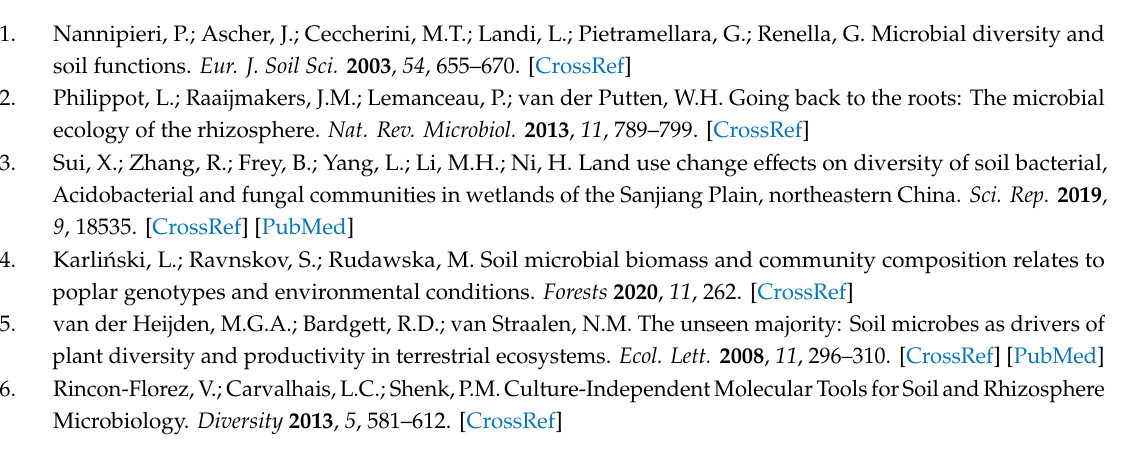
Table S1: T-RFs detected in a treatment of soil classified as Brunic Arenosol (S1) DNA sample after HaeIII digestion of the ( a ) 16S rDNA bacteria, ( b ) 16S rDNA archaea, ( c ) ITS1 fungi PCR products. Number “1” represents the presence of a fragment and “0” means absence. The relative abundance is the percentage of each fragment calculated based on the total area. The value after ± means standard deviation. Table S2: T-RFs detected in a treatment of soil classified as Abruptic Luvisol (S2) DNA sample after HaeIII digestion of the ( a ) 16S rDNA bacteria, ( b ) 16S rDNA archaea, ( c ) ITS1 fungi PCR products. Number “1” represents the presence of a fragment and “0” means absence. The relative abundance is the percentage of each fragment calculated based on the total area. The value after ± means standard